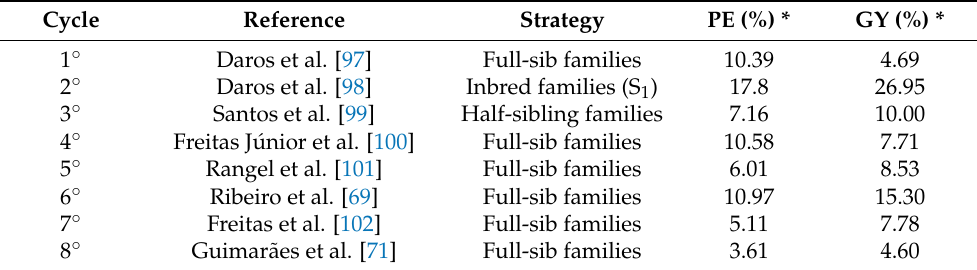
Table 3. Genetic gains across recurrent selection cycles in the UNB-2U population. Cycle Reference Strategy PE (%) * GY (%) * 1